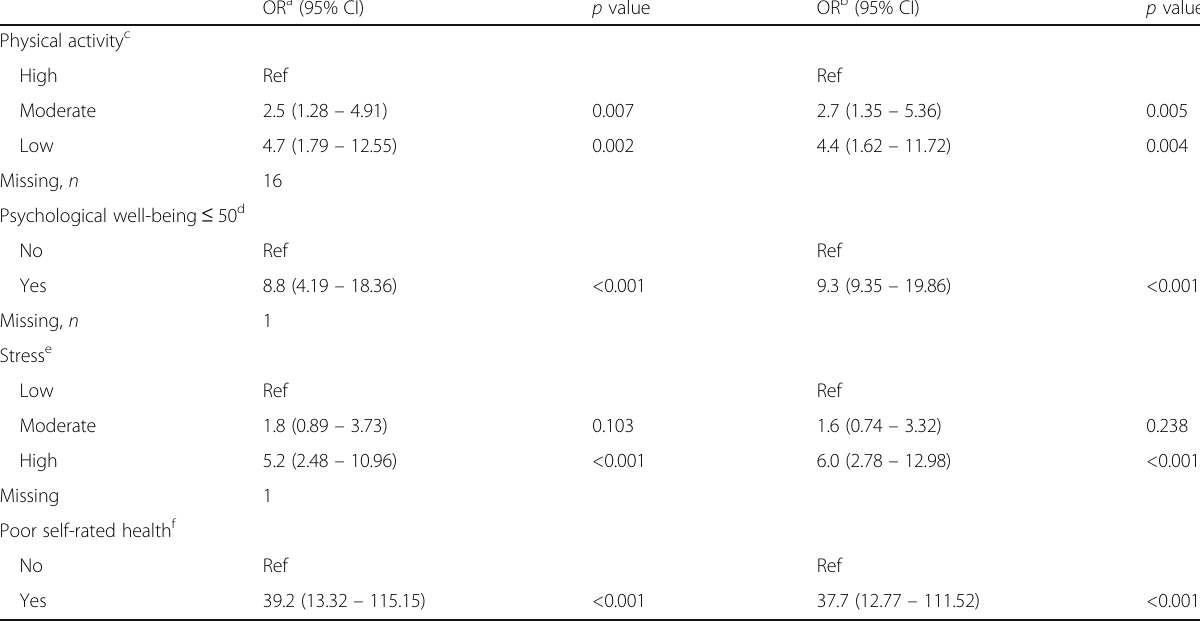
Table 2 Odds ratios of co-existing M, TTH and NP and health-related variables controlled for educational